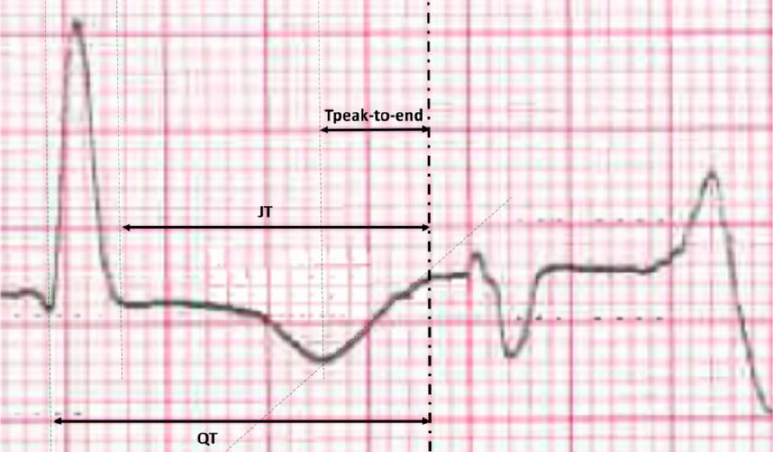
Figure 1. Method of manual measurement for QT, JT, and Tpeak-to-end intervals at the moment of most severe bradycardia.